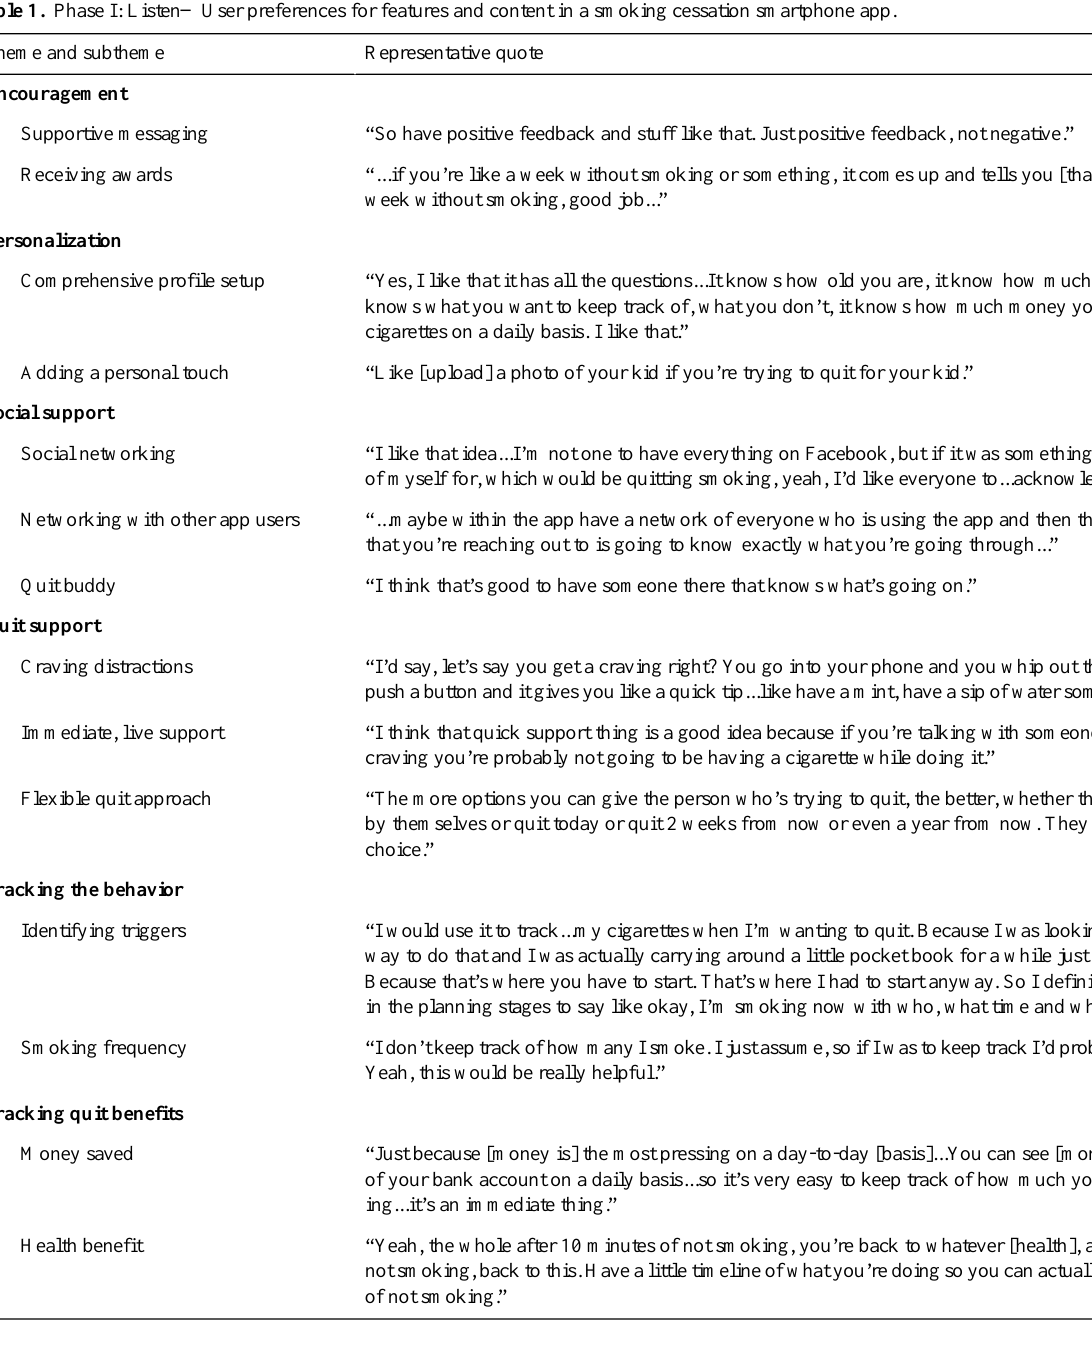
Table 1. Phase I: Listen—User preferences for features and content in a smoking cessation smartphone app.